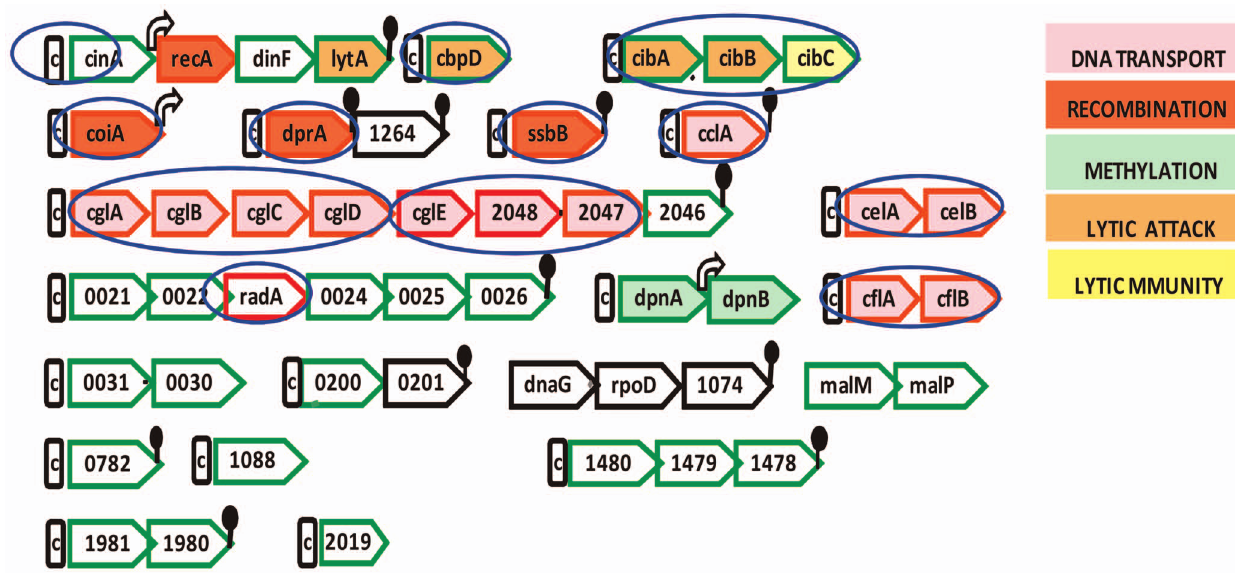
Figure 1. Organization of late genes of the S.pneumoniae competence regulon. Internal deletion mutants studied in this paper are indicated by blue ovals. C represents the cinbox promoter, TACGAATA. Fill colors symbolize the functions of proteins, as indicated by the key on the right. Bent arrow and lollipop stand for constitutive promoter and terminator respectively. Red borders indicate genes required for transformation; green borders indicate genes not required for transformation. Black borders indicate genes whose importance for transformation has not been directly determined. Genes described by numbers (ORF numbers in TIGR4) are those whose functions in competence are unknown. The ORF numbers for named late genes are: cinA (sp1941), cbpD (sp2201), cibA (sp0125), coiA (sp0978), dprA (sp1266), ssbB (sp1908), cclA (sp1808), cglA (sp2053), celA (sp0054), cflA (sp2208). The late gene clusters and associated cinbox are as in Peterson et al [9], but without cases of apparent read-through transcription identified in